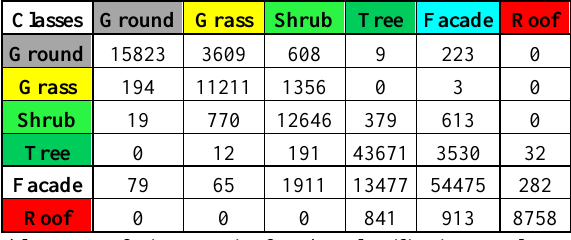
ground and z- component of the normal vector are used. In their Özdemir and Remondino (2019), and height above ground is explained in Özdemir et al. (2019).